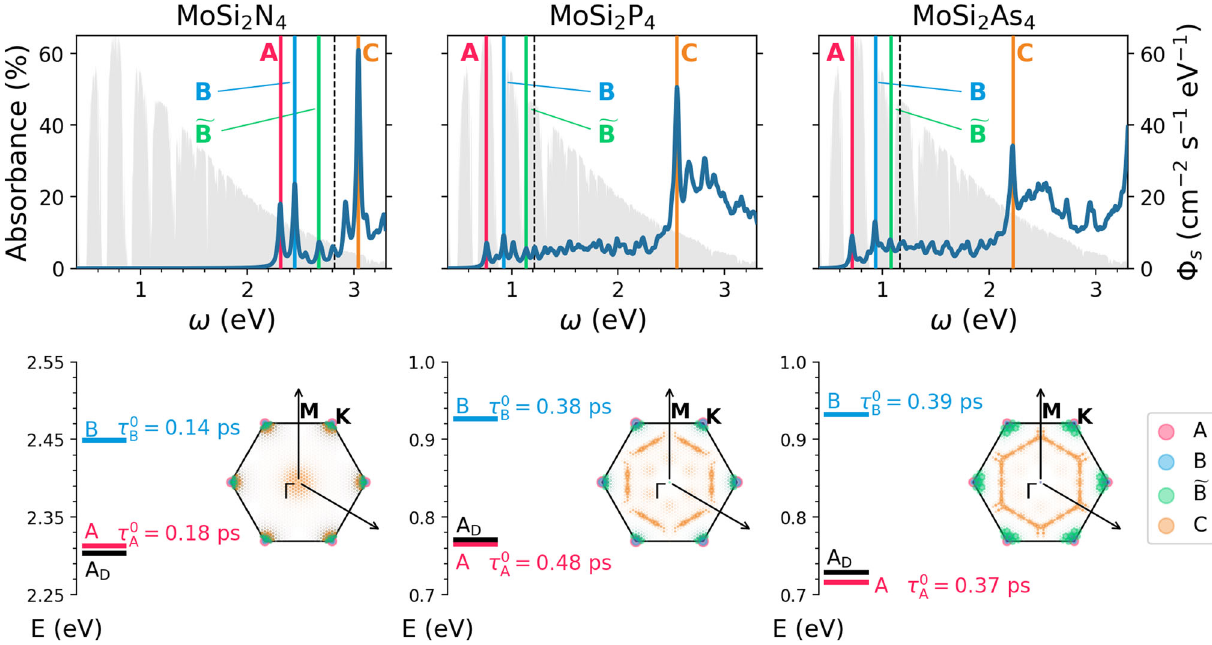
Fig. 3 Absorption spectra and exciton radiative lifetimes. Upper panels: Absorption spectra computed at the BSE level. The dashed vertical lines mark the G 0 W 0 bandgaps. Lower panels: Intrinsic radiative lifetimes of excitons A and B at 0 K, and exciton weights in the Brillouin zone. A D denotes the dark exciton.